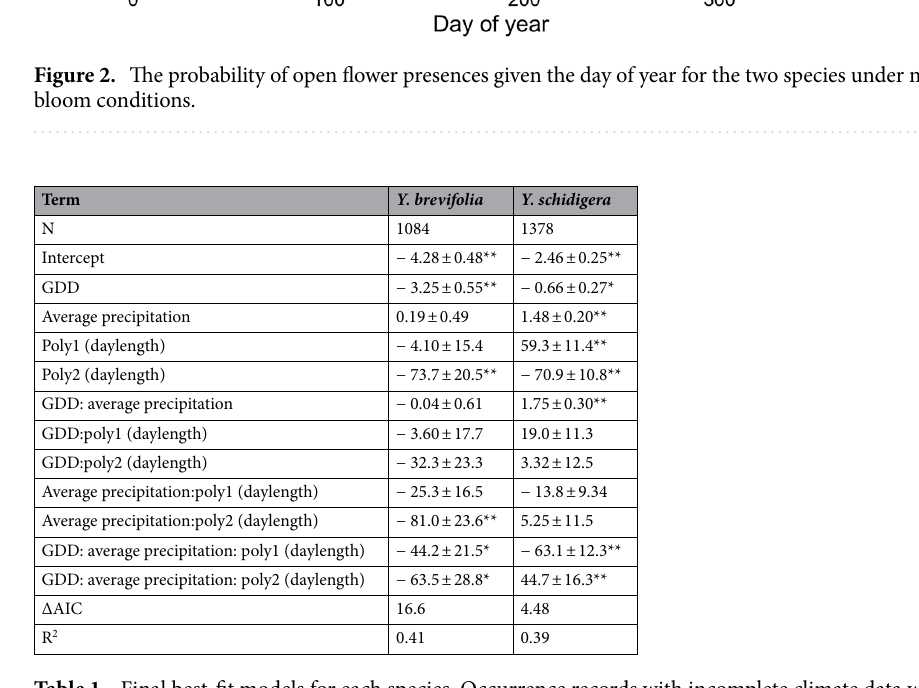
Table 1. Final best-fit models for each species. Occurrence records with incomplete climate data were filtered from the datasets used to fit these models. The best model includes a three-way interaction between growing degree days, precipitation, and photoperiod. A star is used to denote p < 0.05 and a double star indicates p <